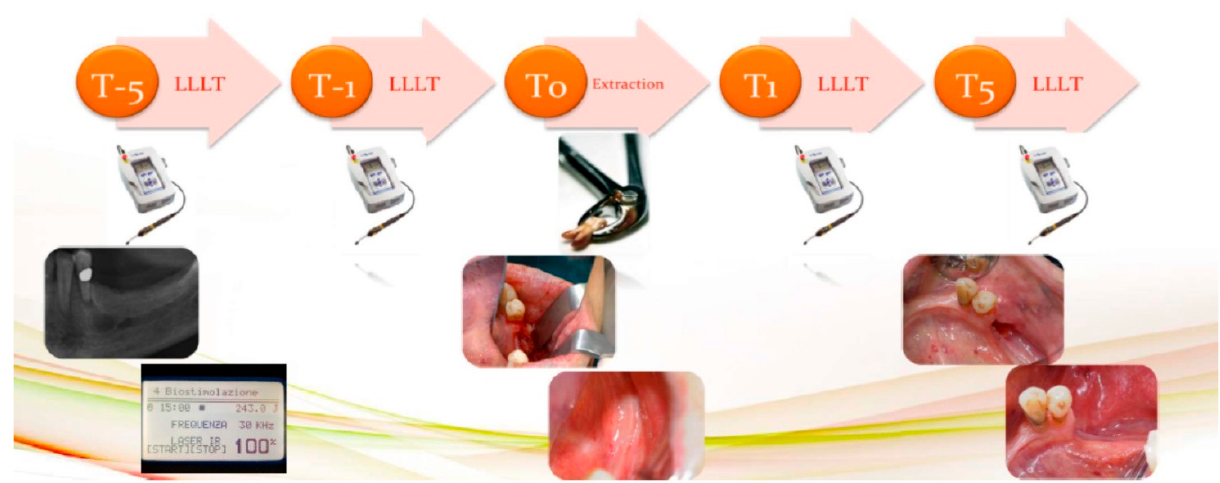
Figure 1. Protocol scheme of the preventive PBM applications in patients needing minor oral surgery interventions that cannot interrupt the drug assumption.